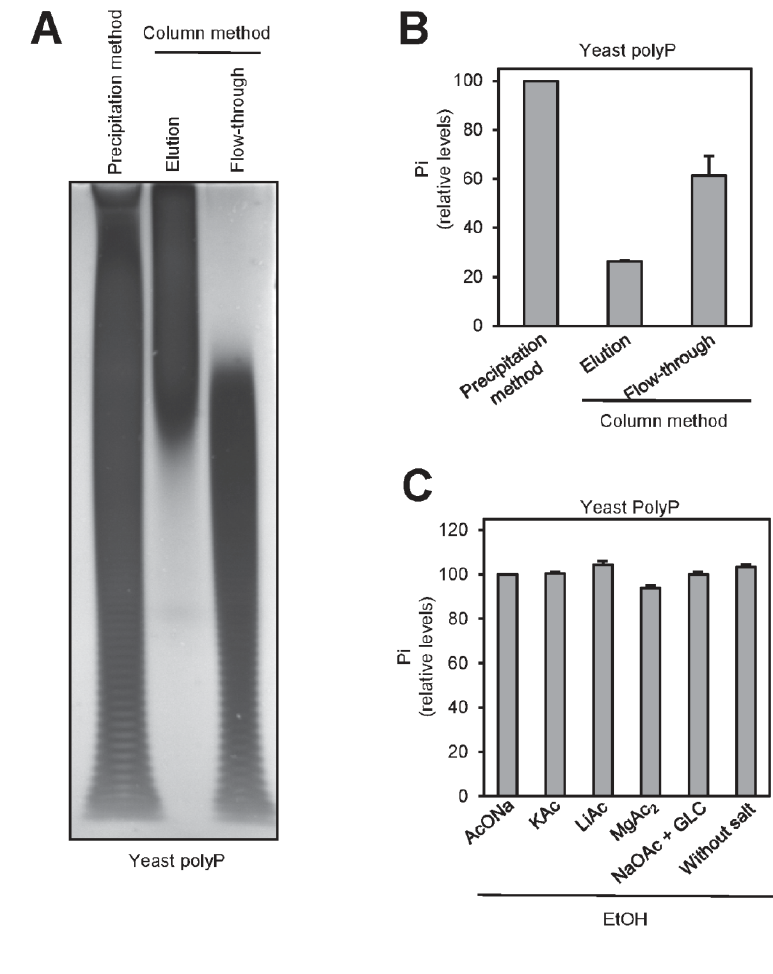
FIGURE 3: Ethanol precipitation method yields a broader spectrum of polyP sizes than affinity column purification. (A) PAGE and DAPI staining of polyP differently purified. polyP was extract- ed using the neutral phenol/chloroform proce- dure from a yeast pellet equivalent to 10 7 loga- rithmically growing yeast cells. The aqueous phase was treated with DNAse and RNAse solu- tion, and purified by affinity columns or by eth- anol precipitation. The resulting polyP fractions: precipitated (in the case of the ethanol) and eluted and flow-through (in the case of the af- finity column) were analyzed by PAGE followed by DAPI staining. (B) Percentage of polyP rela- tive to the purification method. polyP amount was determined using the same fractions ob- tained in panel A. The graph represents the Mean ± SEM from 3 independent experiments. (C) Relative amount of polyP obtained after the precipitation of polyP in the presence of differ- ent monovalent salts, divalent salts and a carri- er. Aqueous phase from panel A was used. The graph represents the percentage of polyP rela- tive to precipitation with NaOAc. Mean ± SEM from 3 independent experiments is shown. GLC,